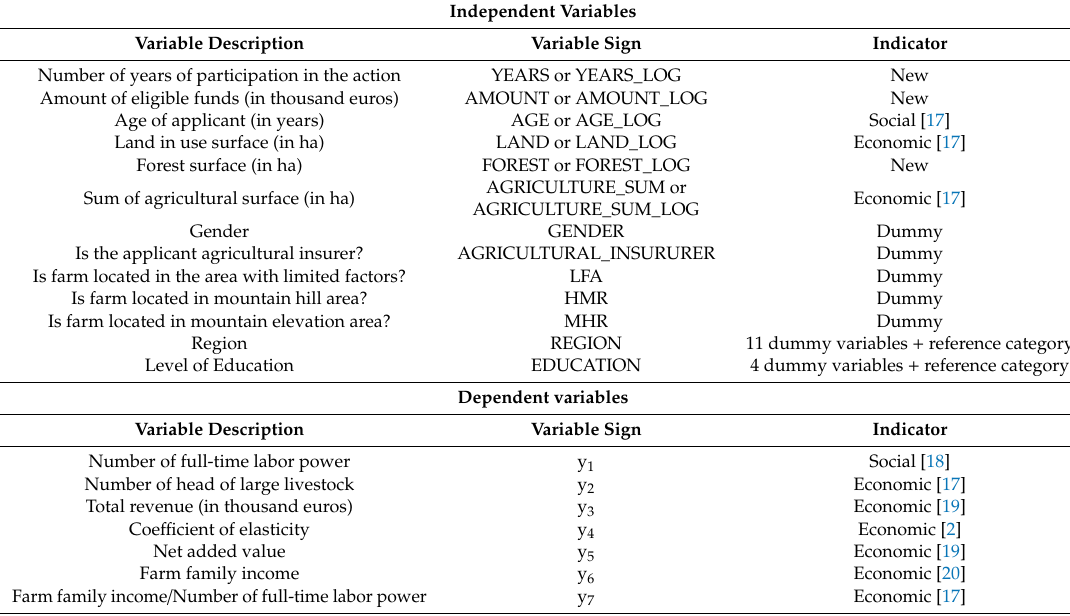
Table 1. Input data